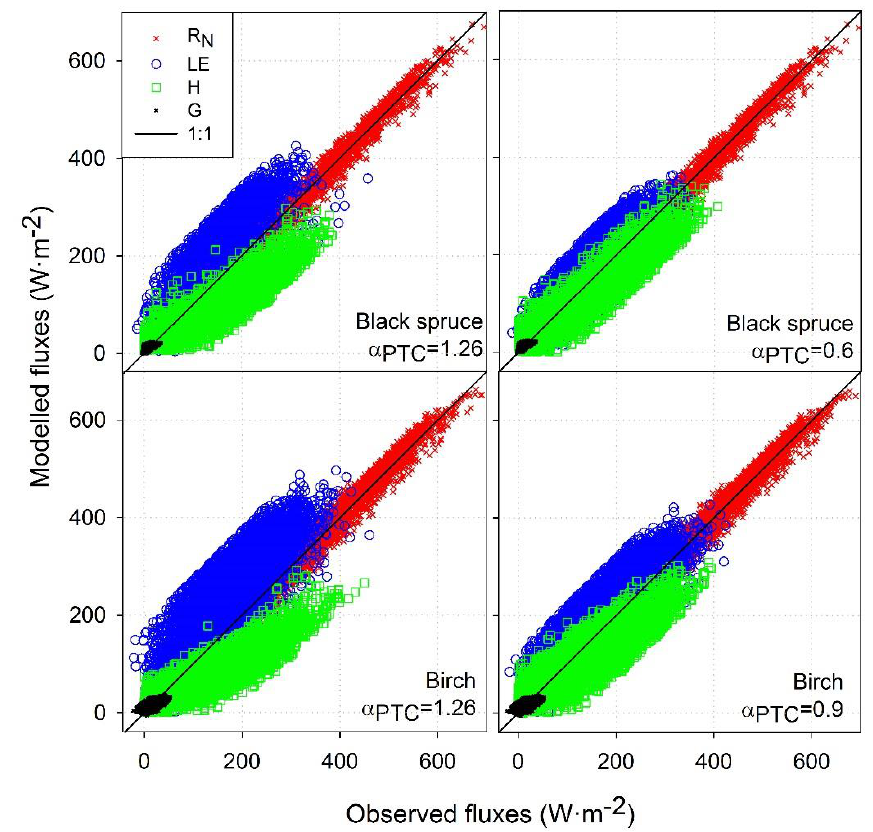
Figure 2. Comparison of modelled vs. measured 30-min fluxes using an initial TSEB α PTC value of 1.26 at both settings, 0.6 for black spruce setting, and 0.9 for birch setting. Perfect agreement is represented by the 1:1 line.